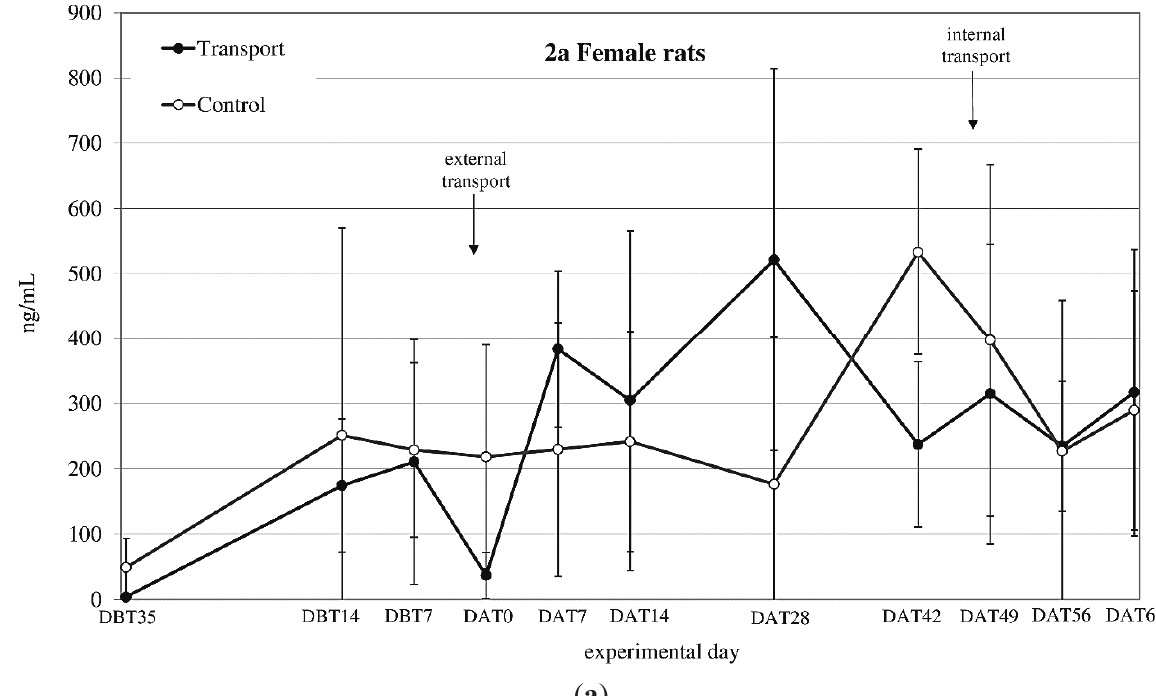
Figure 2. Averaged plasma corticosterone (CORT) levels in ng/mL (mean ± SD) at 11 sampling moments in female ( a ) and male ( b ) Wistar Unilever (WU) rats, DBT: day before transfer, DAT: day after transfer (TP: n = 5, CO: n =